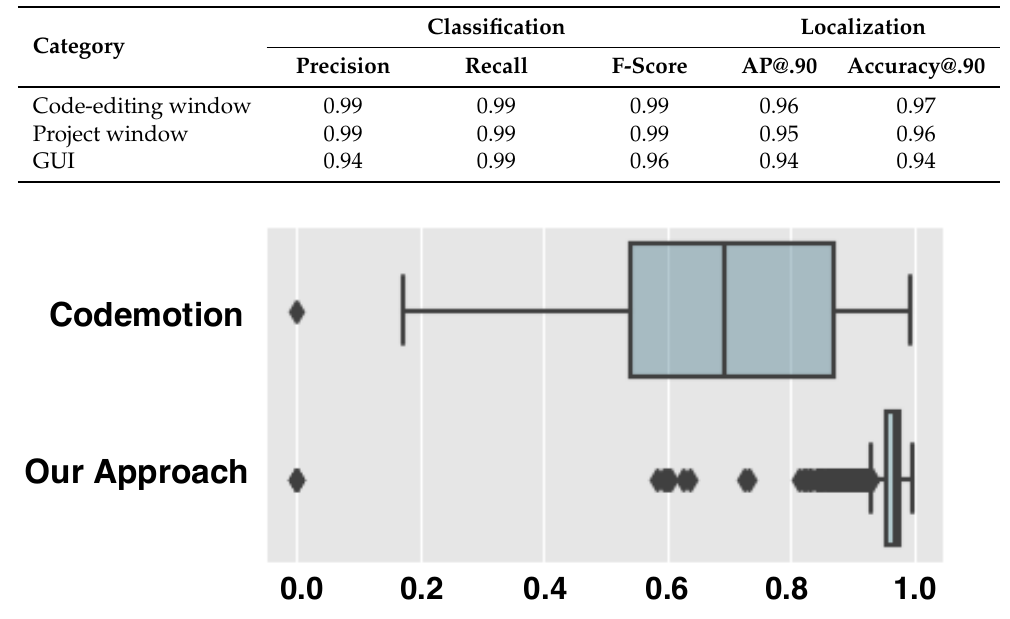
Table 2. The classification and localization results using 10-fold cross-validation. The average precision (AP) and the accuracy is computed with IoU@90.